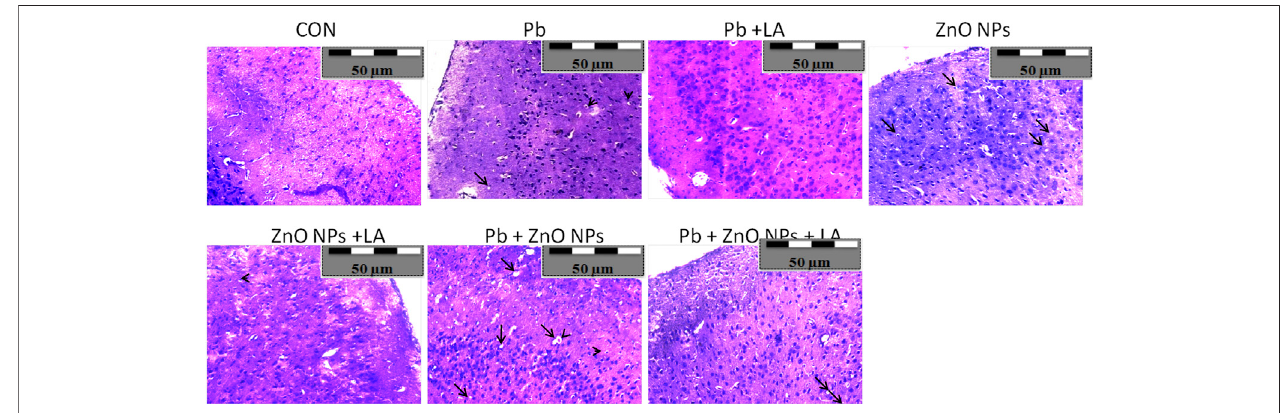
FIGURE 14 | Photographs of histological sections of the cerebral cortex of rats showing (A) hyperchromatic cells (arrow-head) and (B) pyknosis (arrow).